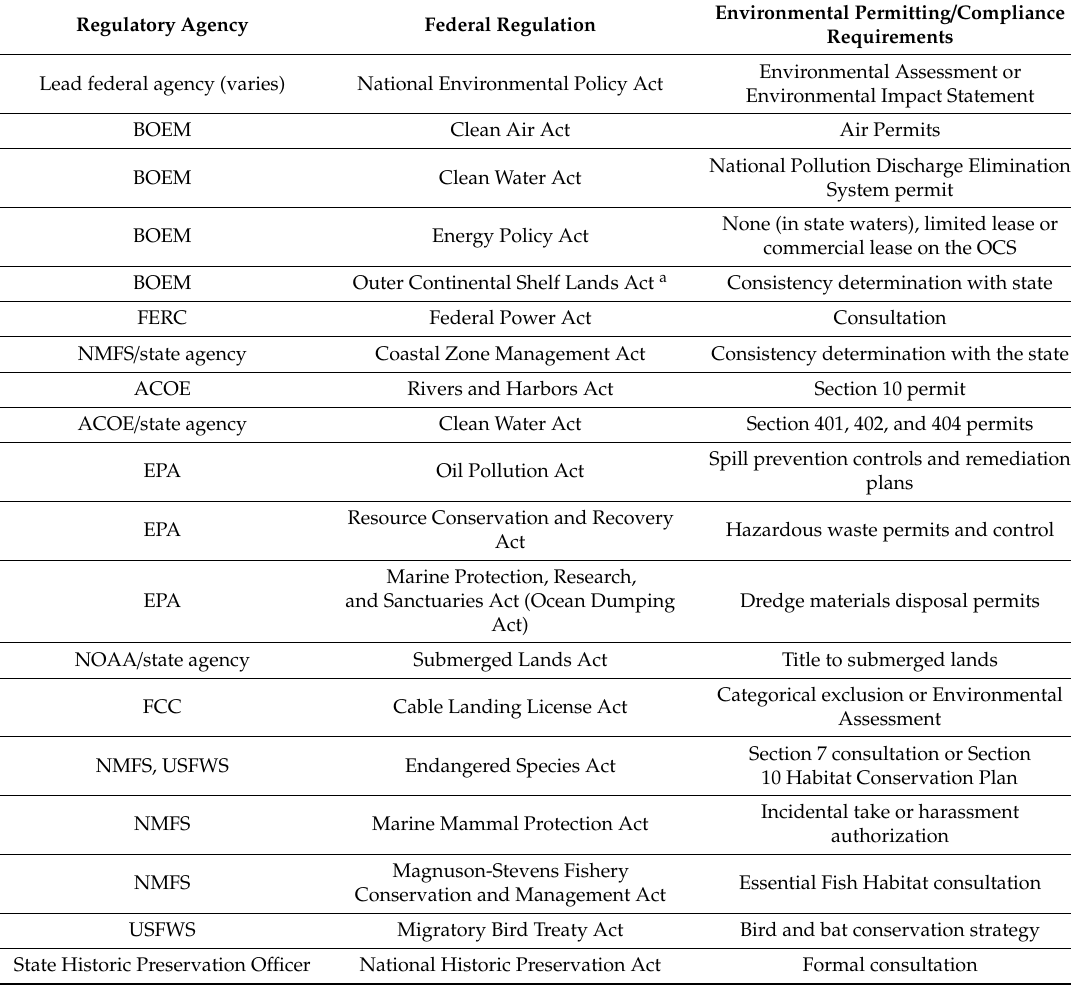
Regulatory Agencies, Federal Regulations, and Types of Environmental Permitting Requirements That May Apply to Marine Industries in the